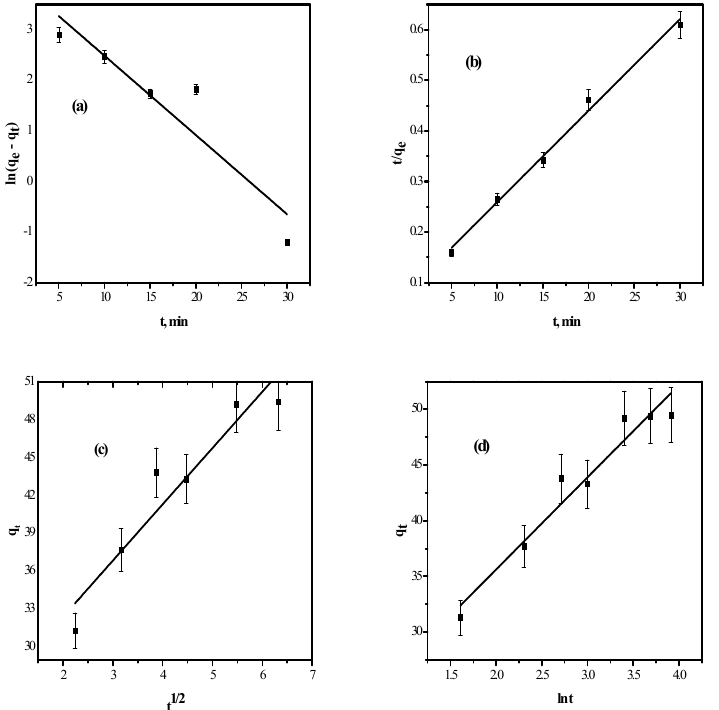
Figure 9. Kinetic models for adsorption system of removal of Pb(II) ion using GA/MNPs: ( a ) pseudo − first − order; ( b ) pseudo-second-order; ( c ) intra-particle diffusion; ( d ) Elovich.